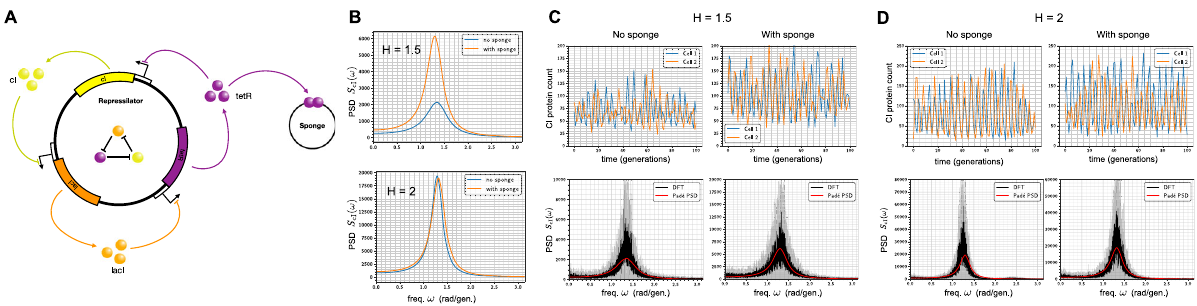
Fig. 3 Improving the repressilator ’ s oscillatory strength. A Depiction of the repressilator network with three gene expression systems whose output proteins cyclically repress each other. When present, the sponge plasmid can bind TetR proteins, thereby raising the derepression threshold of the cI gene. B Shows the effect of the sponge on the PSD. It can be seen that the sponge sharpens the PSD peak for promoter cooperativity H = 1.5 but this effect is lost for H = 2. C Plots the single-cell trajectories with and without the sponge for promoter cooperativity H = 1.5, and they show that the oscillations are more regular in the latter case. Comparison of the PSD estimated with our Padé PSD method with the PSDs estimated with DFT is provided. For these